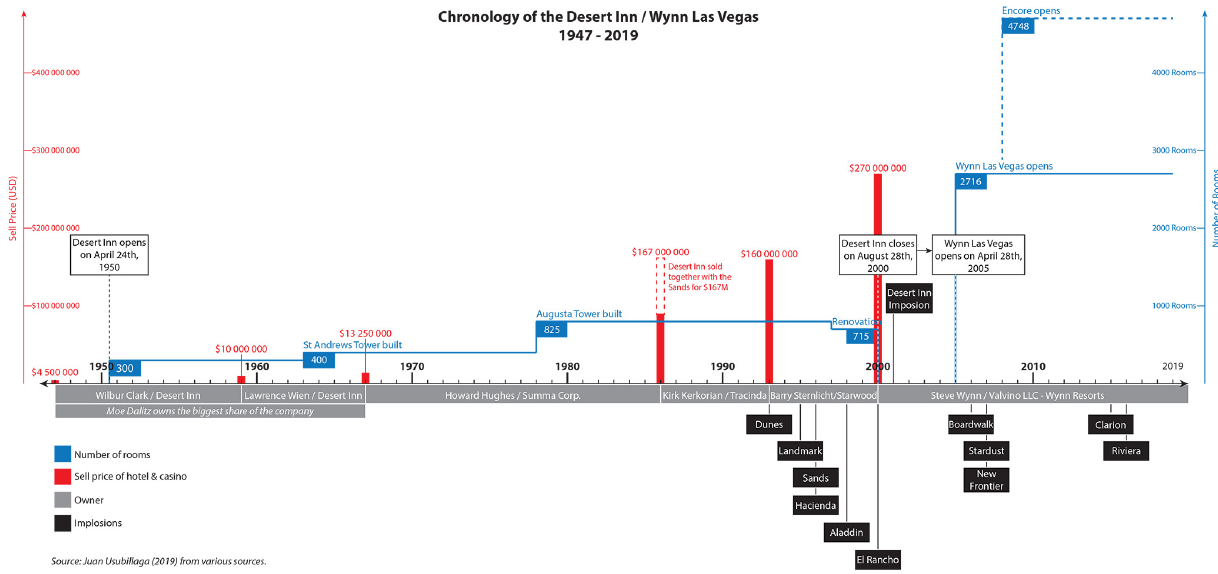
Figure 6. Fits‐and‐starts at a micro‐scale: Desert Inn/Wynn Las Vegas timeline, with the key events being the closing of the Desert Inn in 2000 and the opening of the much larger and much more complex Wynn Las Vegas only five years later in 2005. Source: Courtesy of Juan Usubillaga, based on “Desert Inn chronology” (2005) and Wynn Resorts Limited